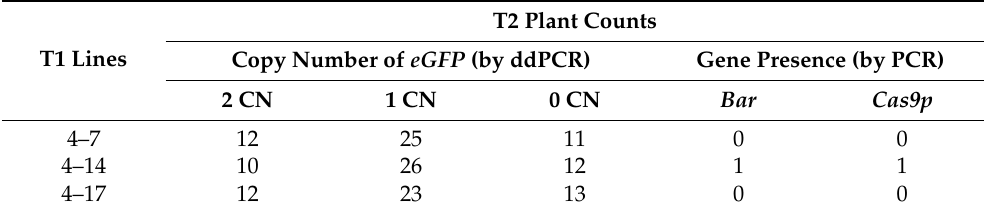
Table 1. Confirmation of target genes in T2 progenies of selected Arabidopsis thaliana (L.) Heyhn. T1 lines carrying single copy insert of pHHCGS- Hsp18.2